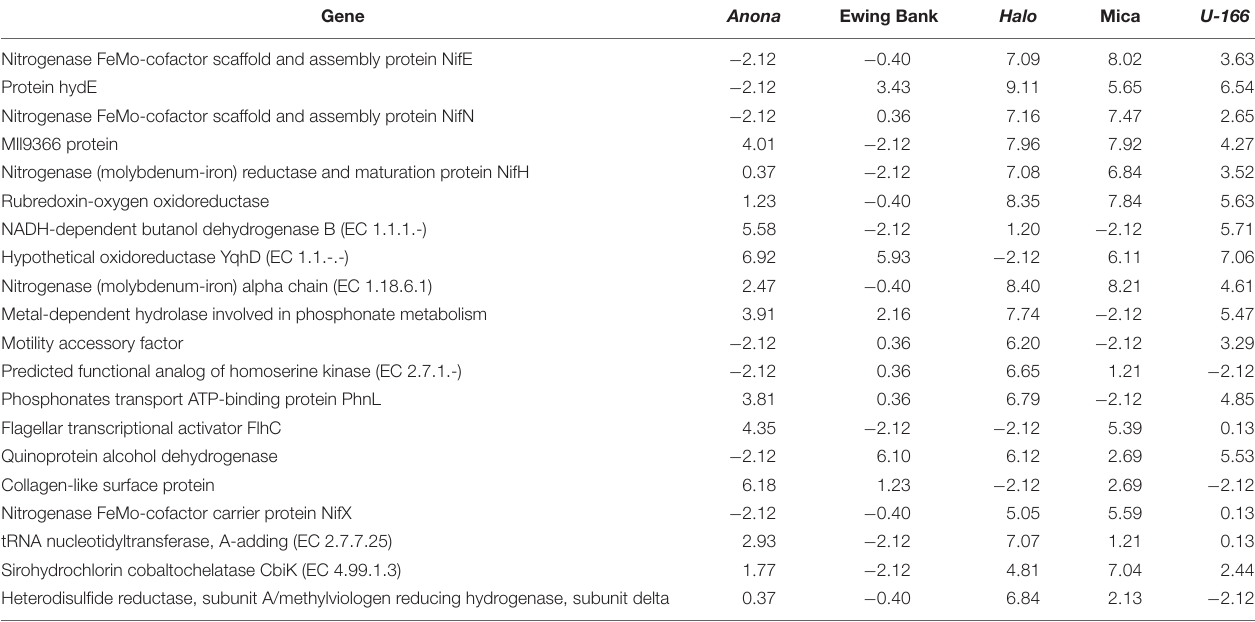
TABLE 4 | Top 20 variable genes between metagenome samples after differential abundance analysis in EdgeR. Gene Anona Ewing Bank Halo Mica U-166 Nitrogenase FeMo-cofactor scaffold and assembly protein NifE − 2 .